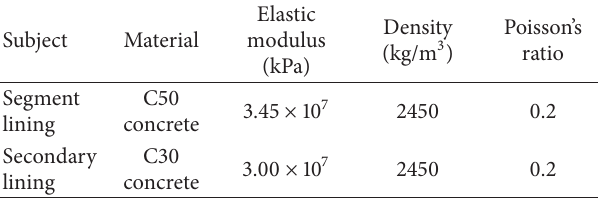
Table 5: Material parameters of double